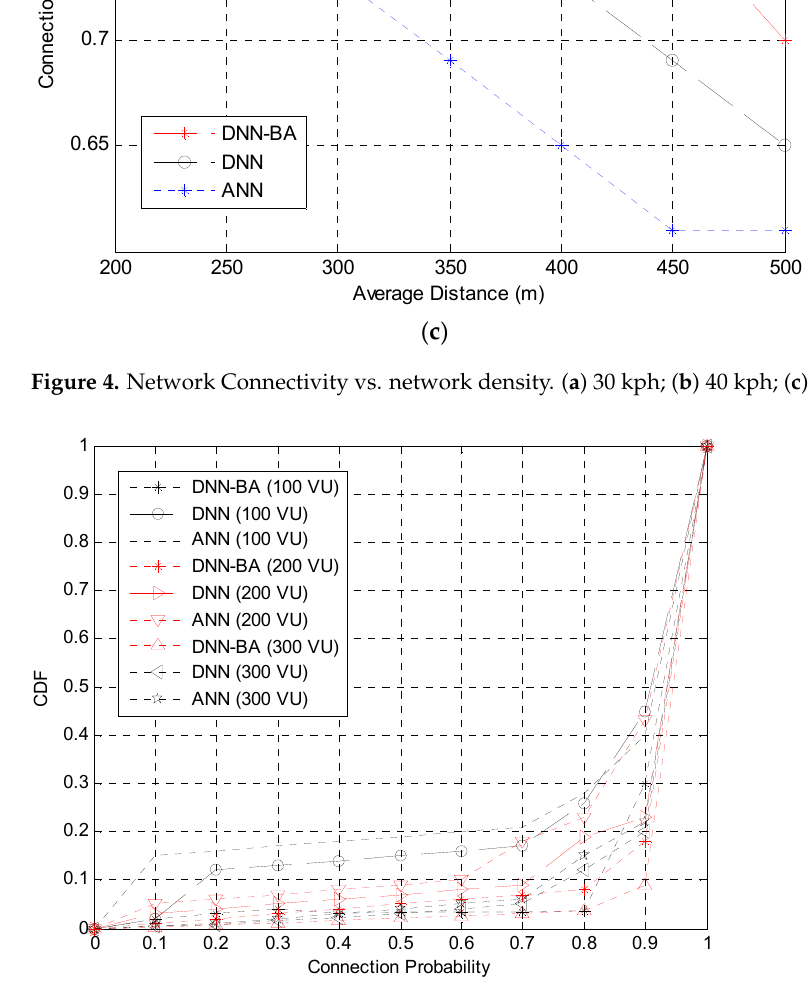
Figure 5. Cumulative distribution function (CDF) of successful connection (100–300 Vehicle units (VU)).